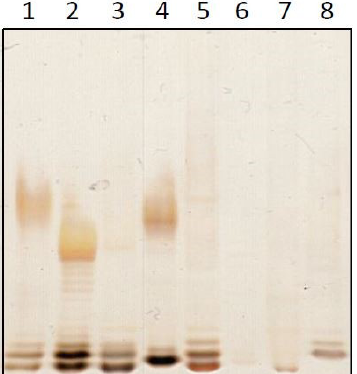
Figure 1. Analysis of crude bacterial extracts. A sodium dodecyl sulfate polyacrylamide gel electrophoresis (SDS-PAGE) of the crude extracts was silver-stained. The lanes reflect endotoxins from E. coli O55:B5 (1), E. coli O113 (2), E. cloacae (3), S. marcescens (4), P. aeruginosa (5), B. cepacia (6), S. maltophilia (7) and R. pickettii (8).